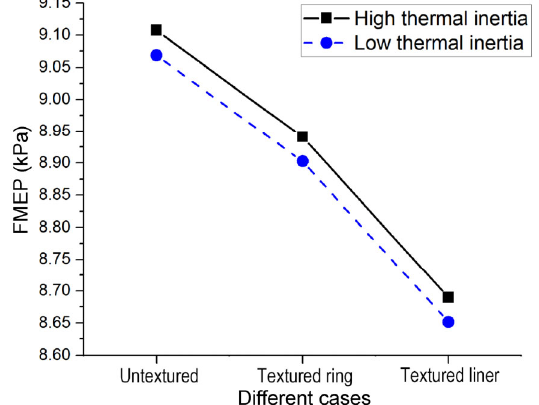
Fig. 11 The effect of coating’s thermal inertia on FMEP results for the untextured or textured